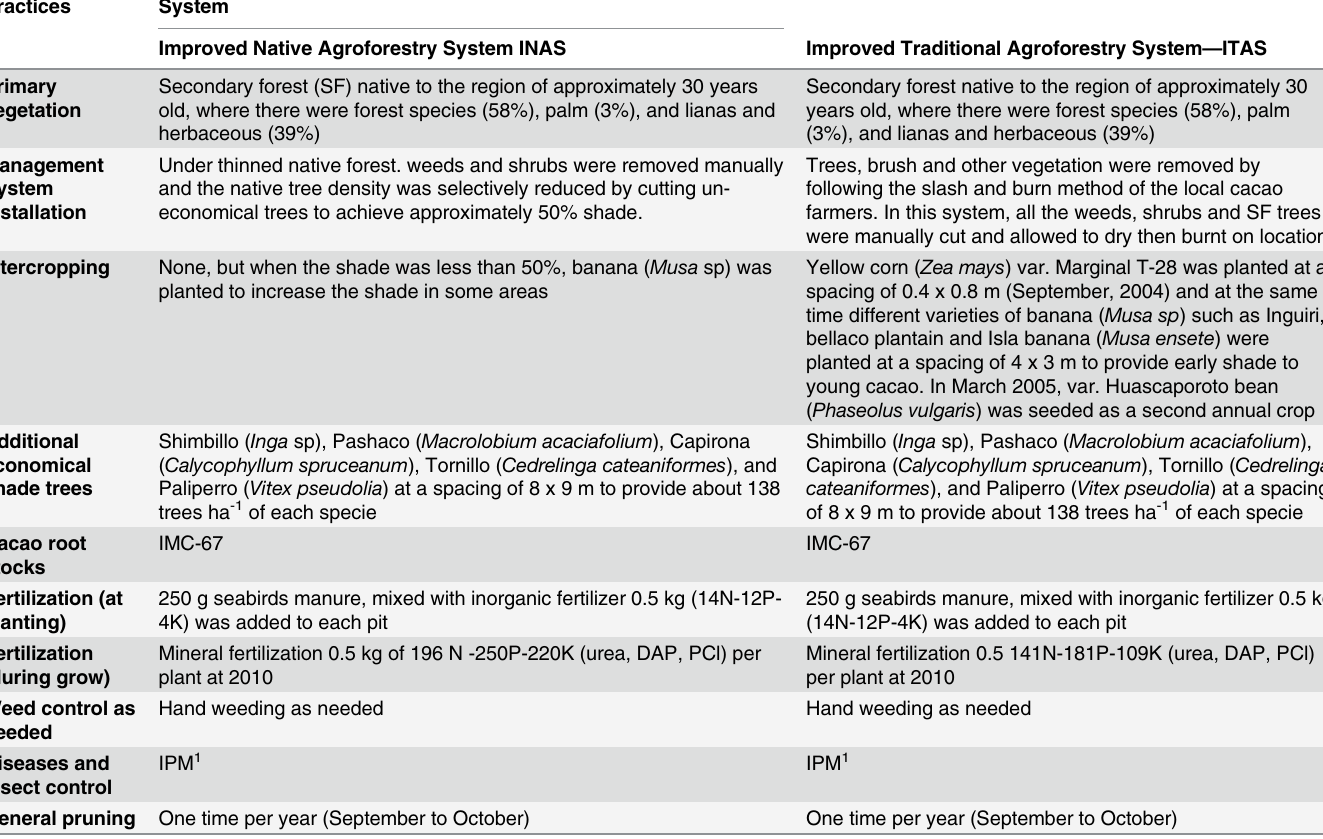
Table 2. Characteristics and Management Practices Adapted for Cacao Agroforestry Management Systems (INAS, ITAS) for 2004 to 2010